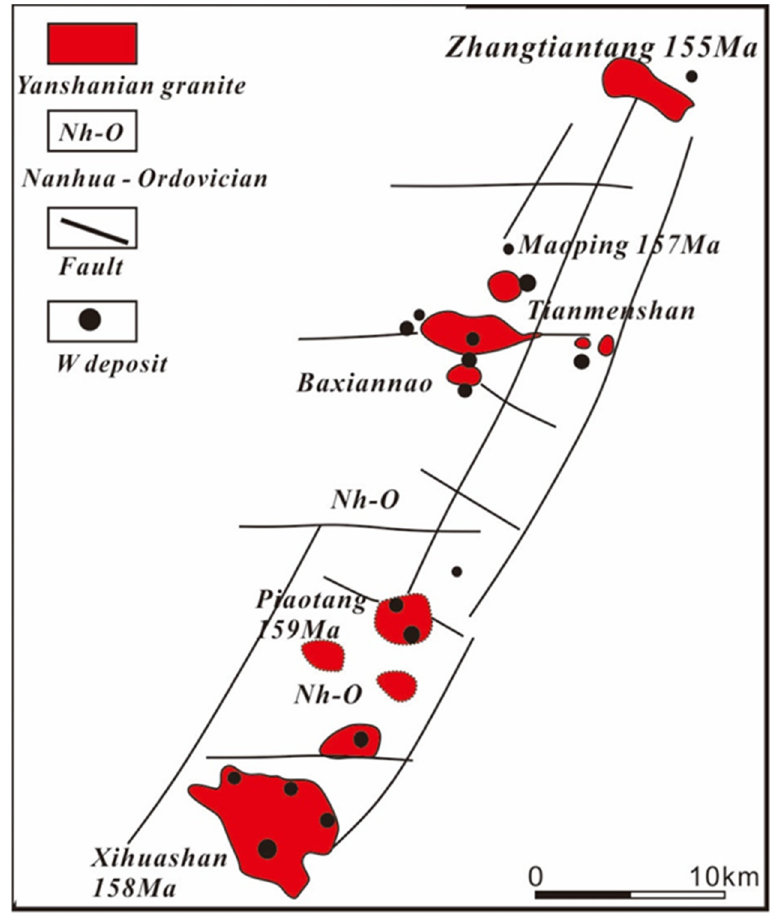
Figure 10. Simplified geological map of the Xihuashan-Zhangtiantang region of South China, showing roughly similar intervals (modified after [172]).